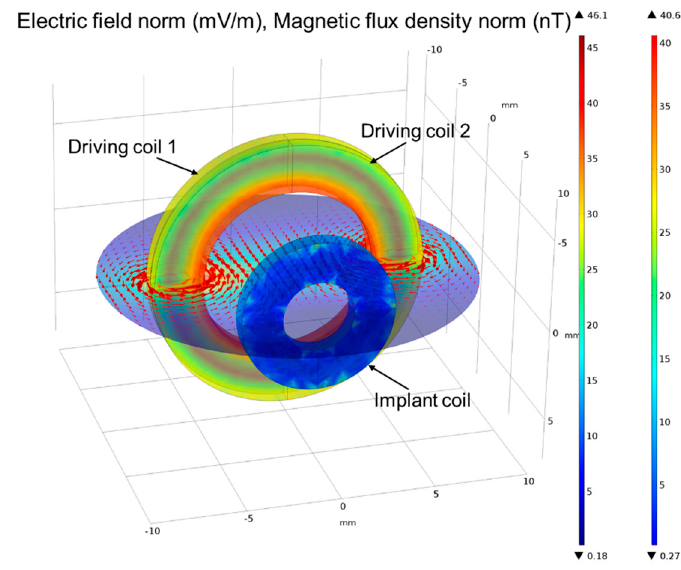
Figure 1. Illustration of an electric field induced by a varying magnetic field.